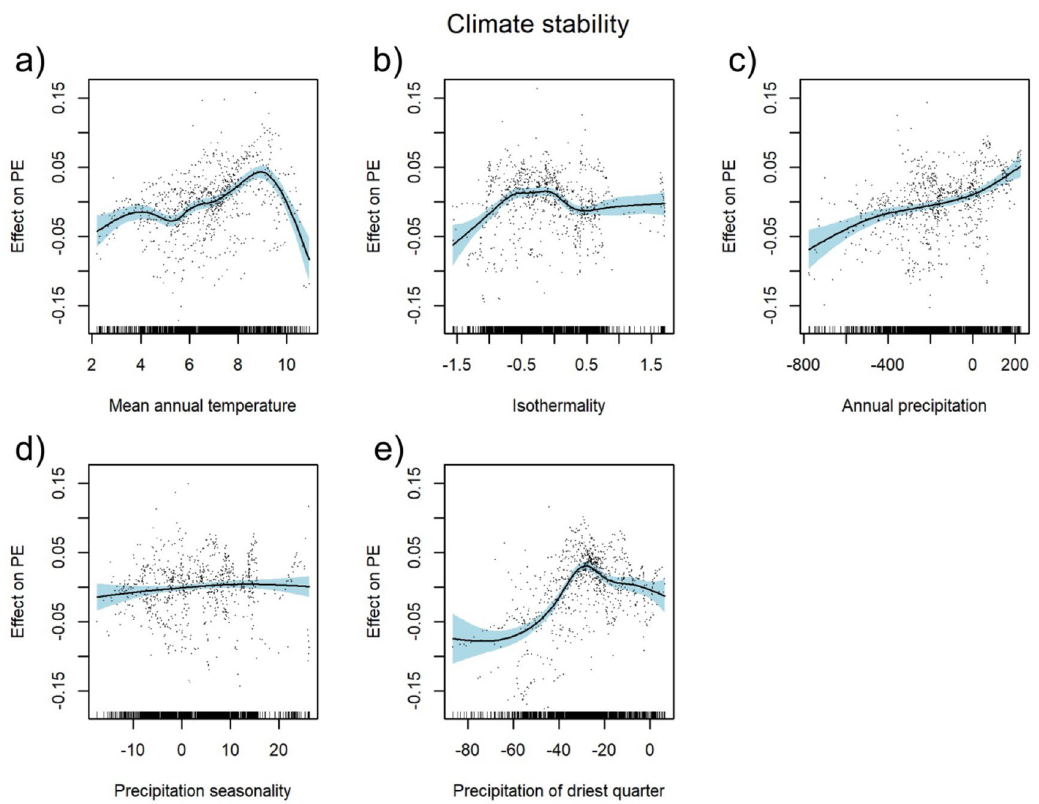
Figure 4. Partial response curves of climatic change predictors with smooth effects in the generalised additive model (GAM). Effect of annual mean temperature [°C] ( a ), isothermality [%] ( b ), sum of annual precipitation [mm] ( c ), precipitation seasonality [%] ( d ), and precipitation of the driest quarter [mm] ( e ); PE: proportion of endemic plant species to overall plant species richness as target variable. For model summary of the GAM